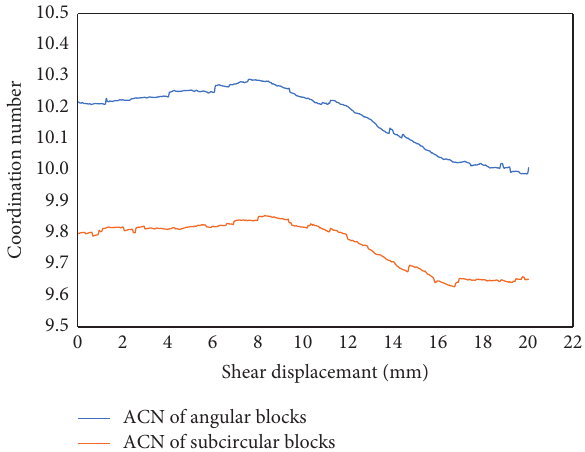
Figure 12: Coordination number comparison of two numerical samples with different grinding roundness at